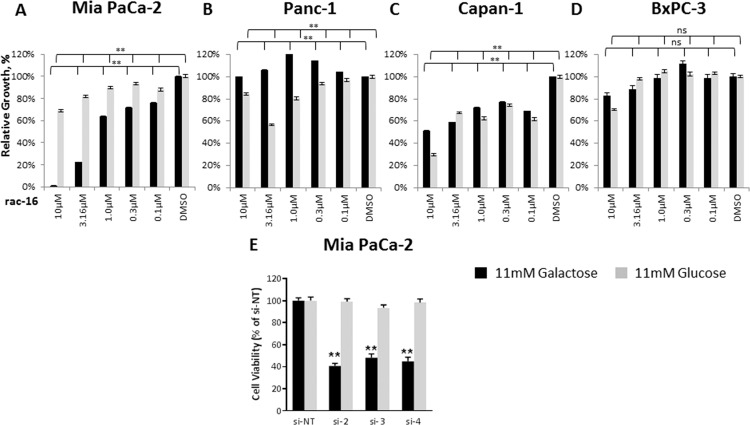
KCa3.1 inhibition affects proliferation.(A) xCELLigence proliferation assay on Mia PaCa-2, (B) Panc-1 (C) Capan-1 and (D) BxPC-3 cells grown in the presence of 11 mM glucose or galactose as the main energy source and treated with increasing concentrations of rac-16, n = 5 for each condition. The slope of the exponential phase of the growth curve was calculated in the complementary software. The relative growth was calculated as the ratio between the slopes of DMSO-and rac-16 treated cells in the appropriate media. (E) Viability assay of Mia PaCa-2 cells transfected with non-targeted siRNA or individual siRNAs against KCNN4. Assay was conducted 72 hours post-transfection, n = 3. ANOVA Bonferroni test was used to compare each of the rac-16 treatments vs DMSO; ns, not significant, p>0.05,*, p-value is 0.01 to 0.05; **, p-value < 0.01.